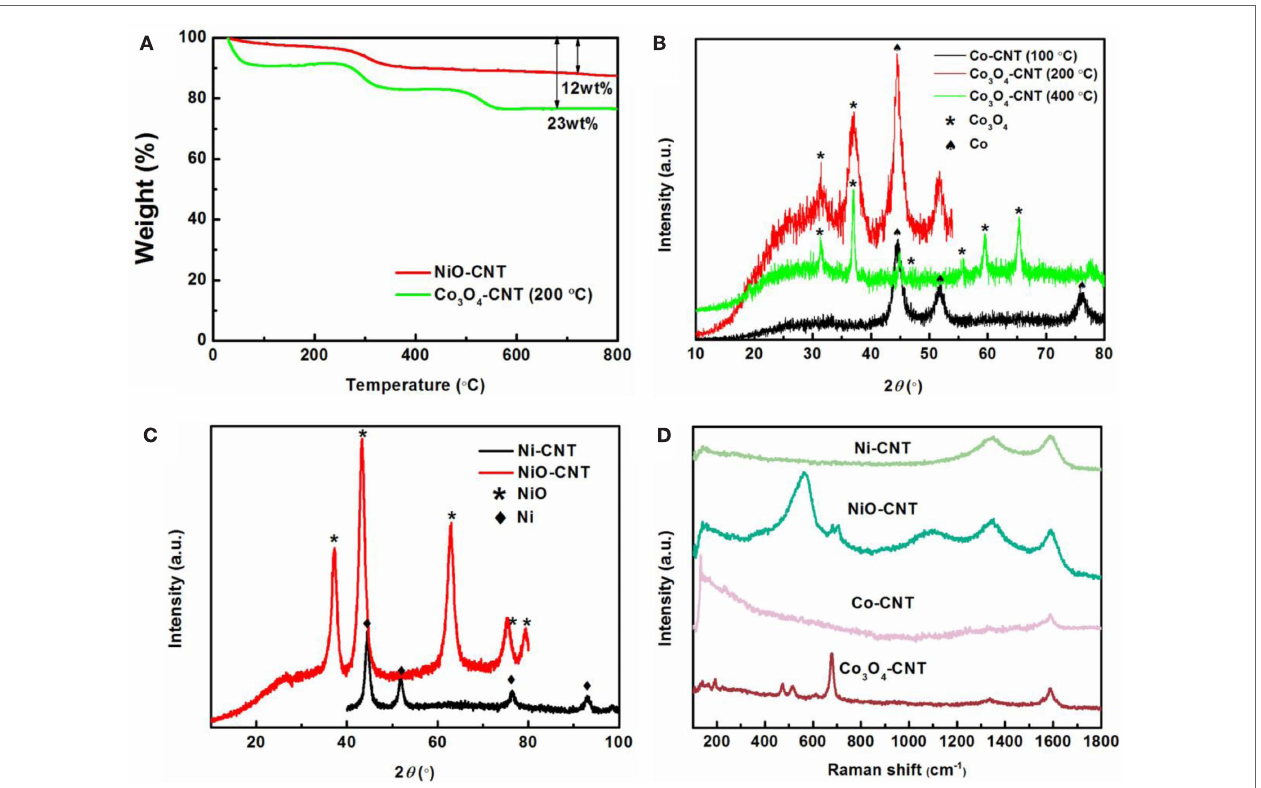
O /SWNT (200°C). (B) XRD patterns of Co-CNT (100°C), Co 3 4